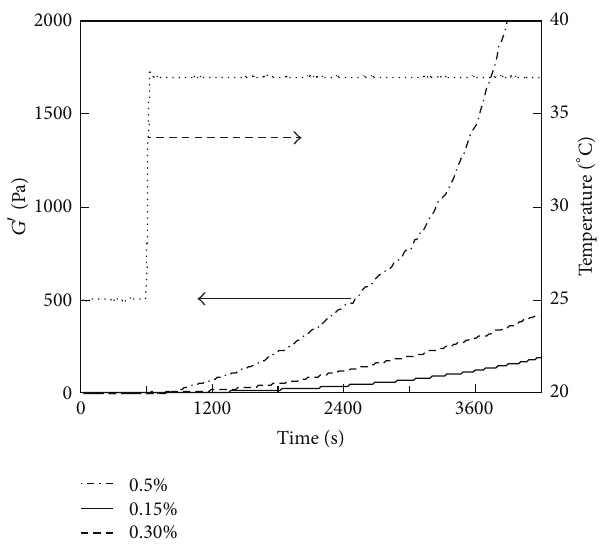
Figure 8: Storage modulus ( G 󸀠 ) of PSC/1mM genipin solutions measured by a temperature-responsive gelation test. PSC concentra- tions were (a) 0.15% and (b) 0.5%. The temperature was maintained at 25 ∘ C for 600s and then increased to 37 ∘ C. Numbers in figures indicate PSC